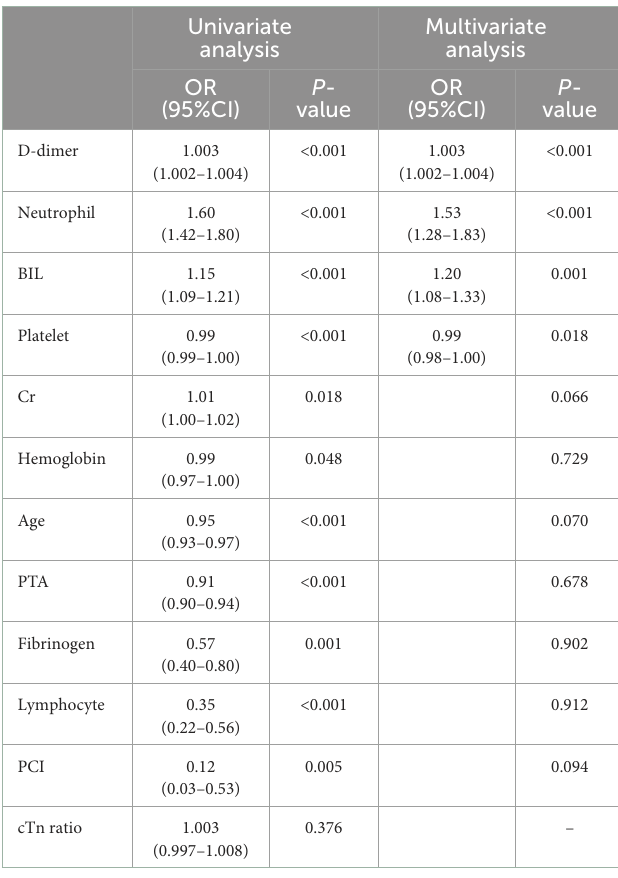
TABLE 5 Univariate and multivariate analysis for differential risk factors for AAS with chest pain onset ≥ 2h in the cTn cohort.